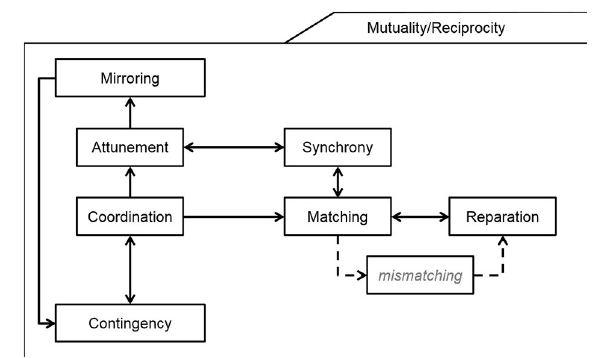
FIGURE 4 | Theoretical model of the relationships among dyadic